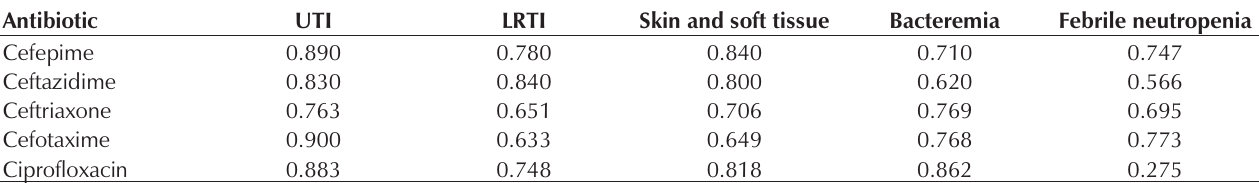
Probability of clinical effectiveness of antibiotics on susceptible infections* Antibiotic UTI LRTI Skin and soft tissue Bacteremia Cefepime